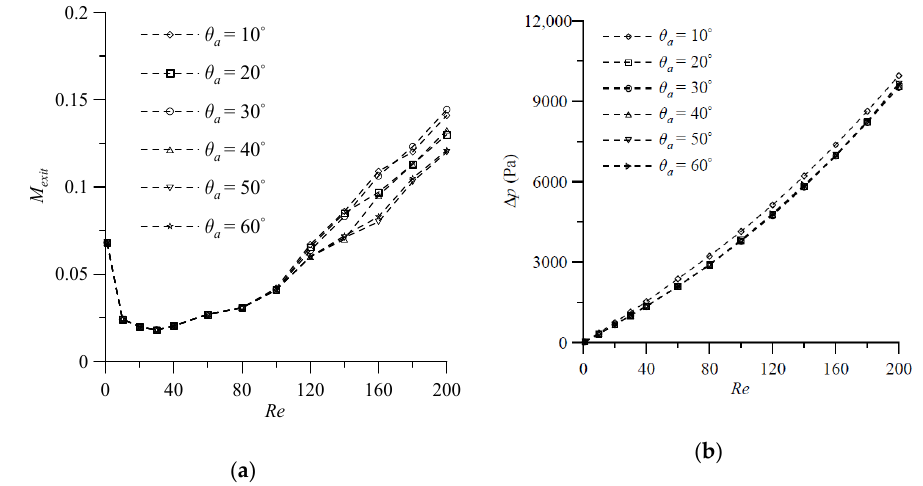
θ Figure 12. E ff ect of angle of attack θ a on ( a ) the degree of mixing, and ( b ) the pressure drop in the Figure 12. Effect of angle of attack a on ( a ) the degree of mixing, and ( b ) the pressure drop in the mixers with d = 3 H , h = 0.75 H , t = 0.25 H and w d = 0.25 H for various Reynolds 0.25 w H = mixers with d = 3 H , h = 0.75 H , t = 0.25 H and for various Reynolds numbers. d